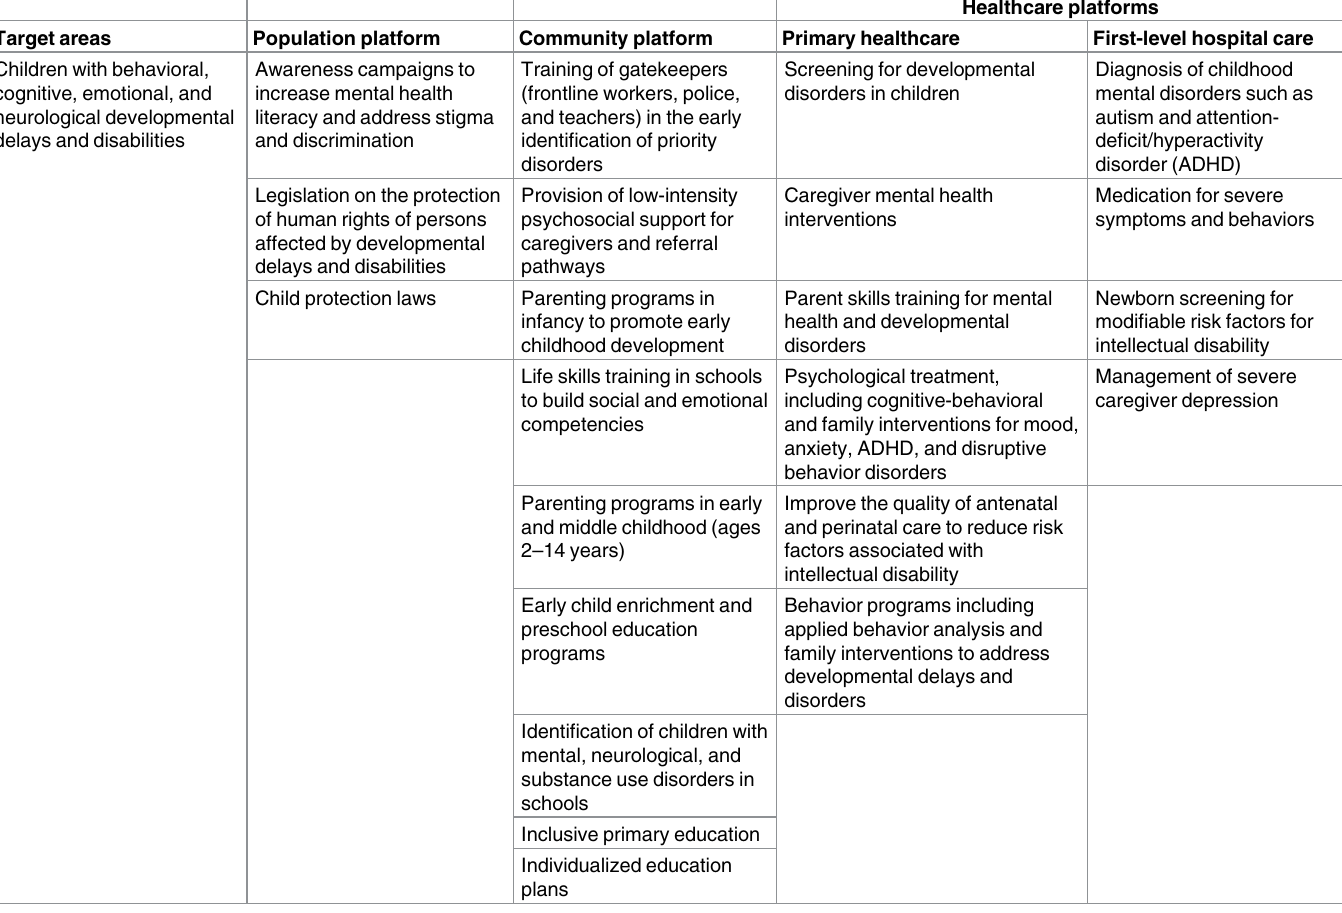
Table 1. Platforms for interventions for children with developmental delays and